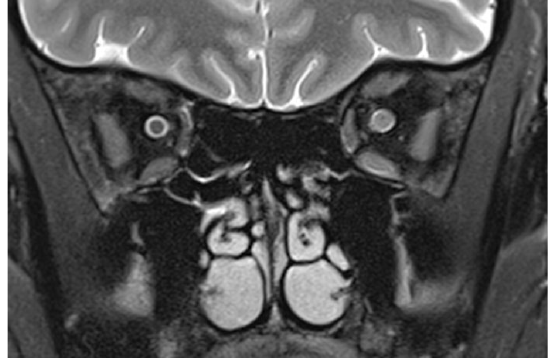
Figure 2. T2-weighted frontal image in a multiple sclerosis patient with optic neuritis. While the subarachnoid space has a normal diameter on the left, an enlarged optic nerve encroaches in the same space, recognizable by the smaller liquor-filled rim of the nerve. Leakage of cerebrospinal liquor after direct laceration of the sheath, however, cannot be counted out. The diffuse signal increase of the nasal retrobulbar space in Figure 1f,g may be explained by cerebrospinal liquor leaking from an injured optic nerve sheath and by